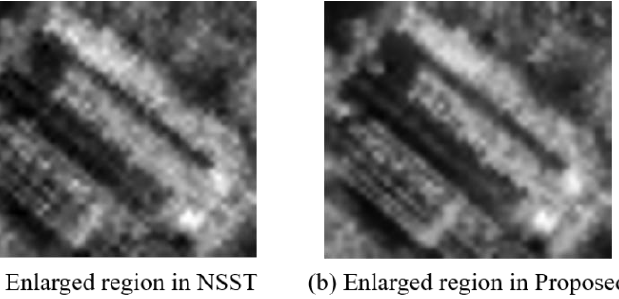
Figure 6. Enlarged marked region in scene 1: ( a ) Enlarged marked region in the NSST fusion; and ( b ) enlarged marked region in the proposed method fusion.